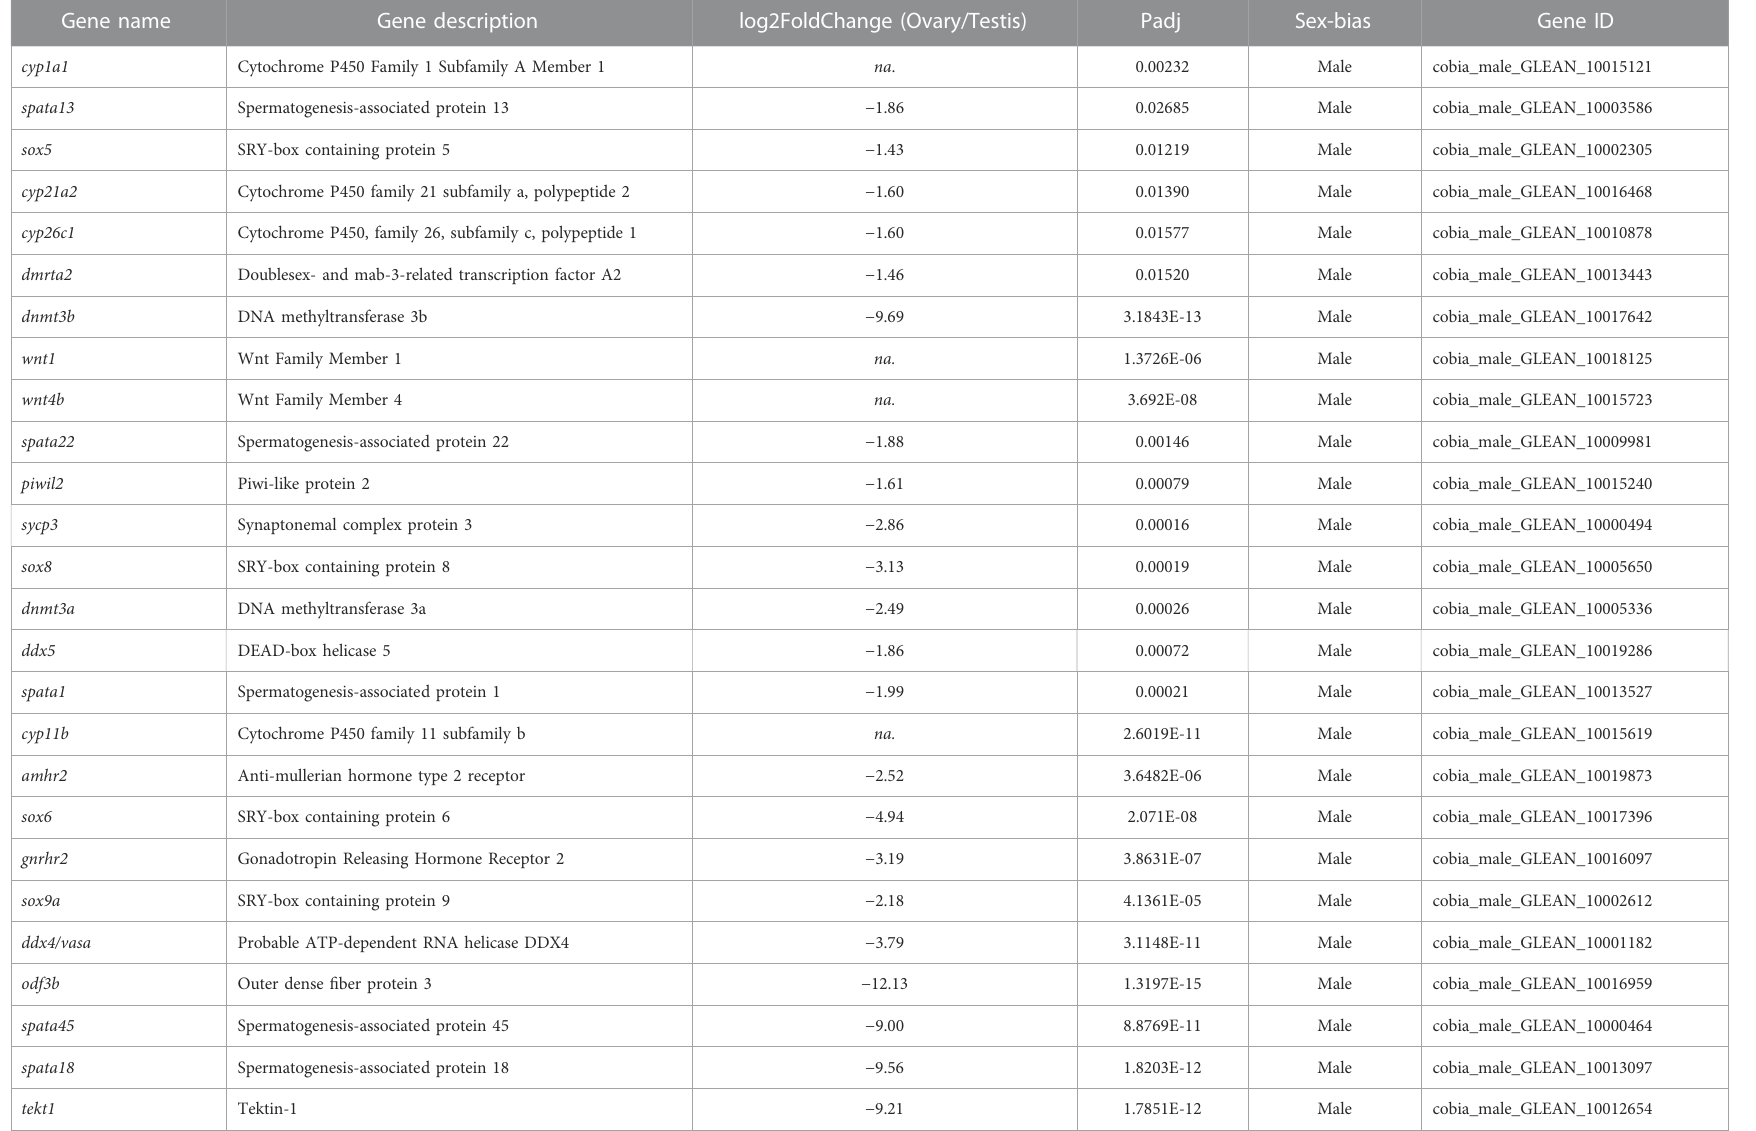
TABLE 1 Candidate sex-associated DEGs identi fi ed in the gonad of Cobia ( “ na. ” : male-speci fi